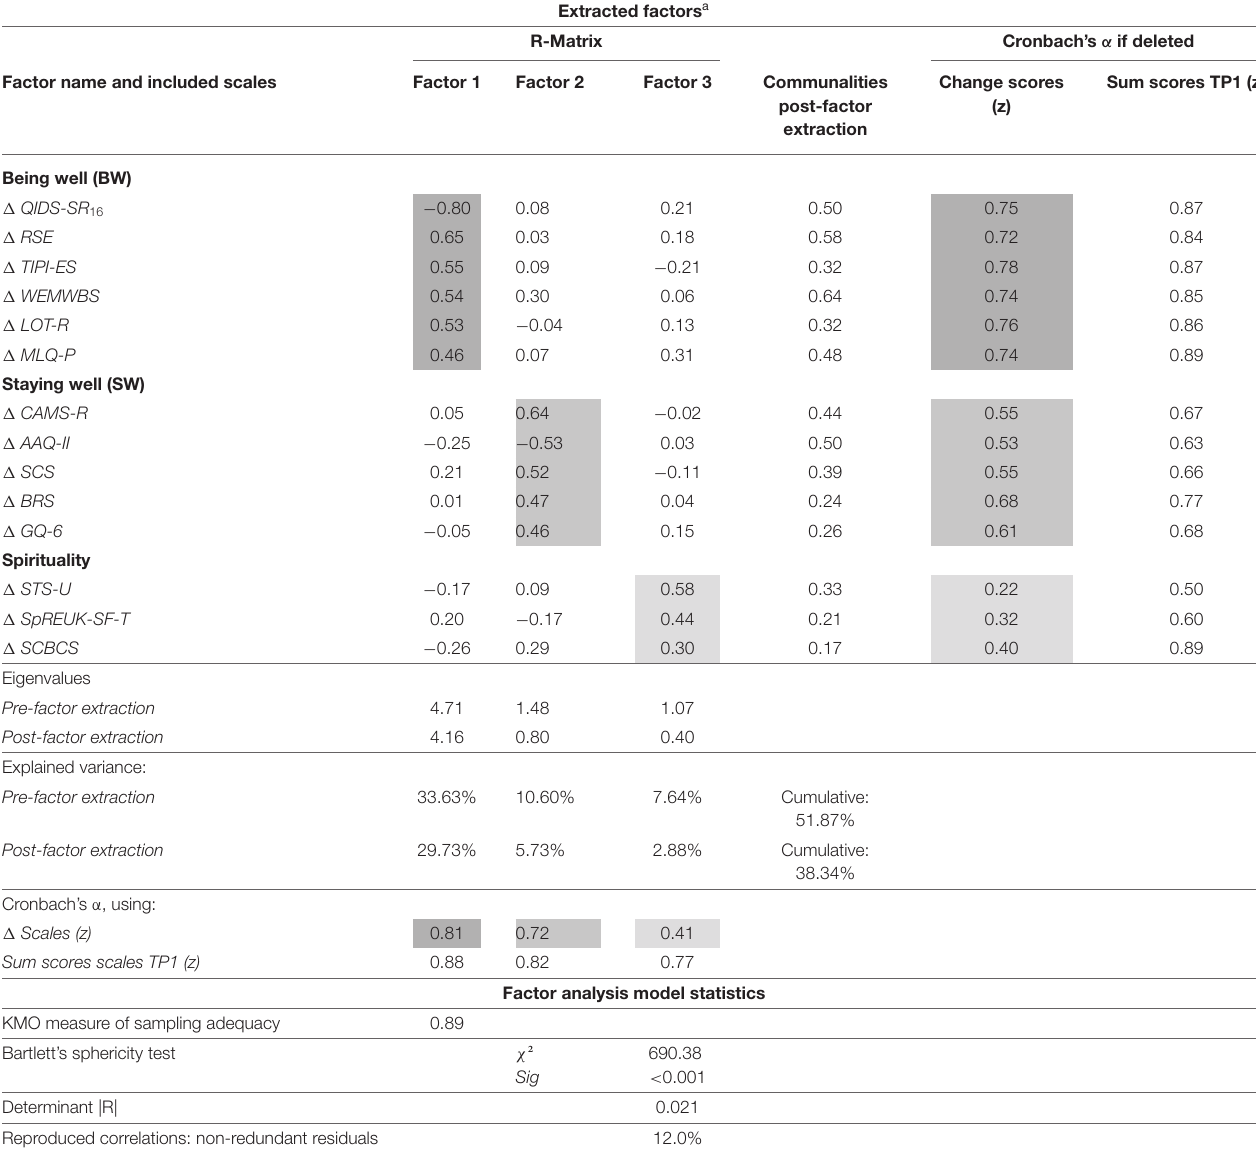
TABLE 5 | Relevant output Exploratory Factor Analysis (EFA); principal axis